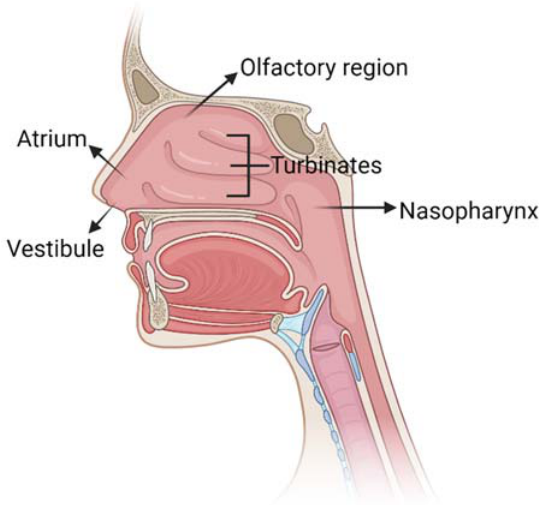
Figure 2. Schematic representation of nose anatomy with its five main regions: vestibule, atrium, turbinates in the respiratory region, olfactory region and nasopharynx. Created with BioRen ‐ der.com.